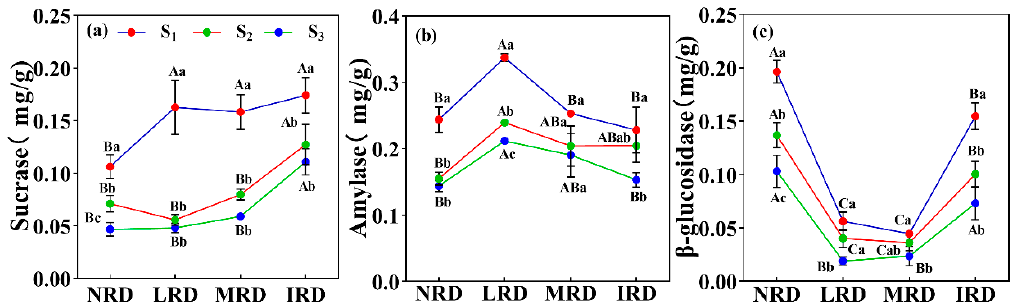
Figure 3. Soil enzyme activities in different (karst rocky desertification) KRD grades. Different capital letters represent different rocky desertification grades of the same soil layer have significant differences, and different small letters represent significant differences between different soil layers of the same rocky desertification grade ( p < 0.05). ( a ) Sucrase, ( b ) Amylase and ( c ) β -glucosidase.